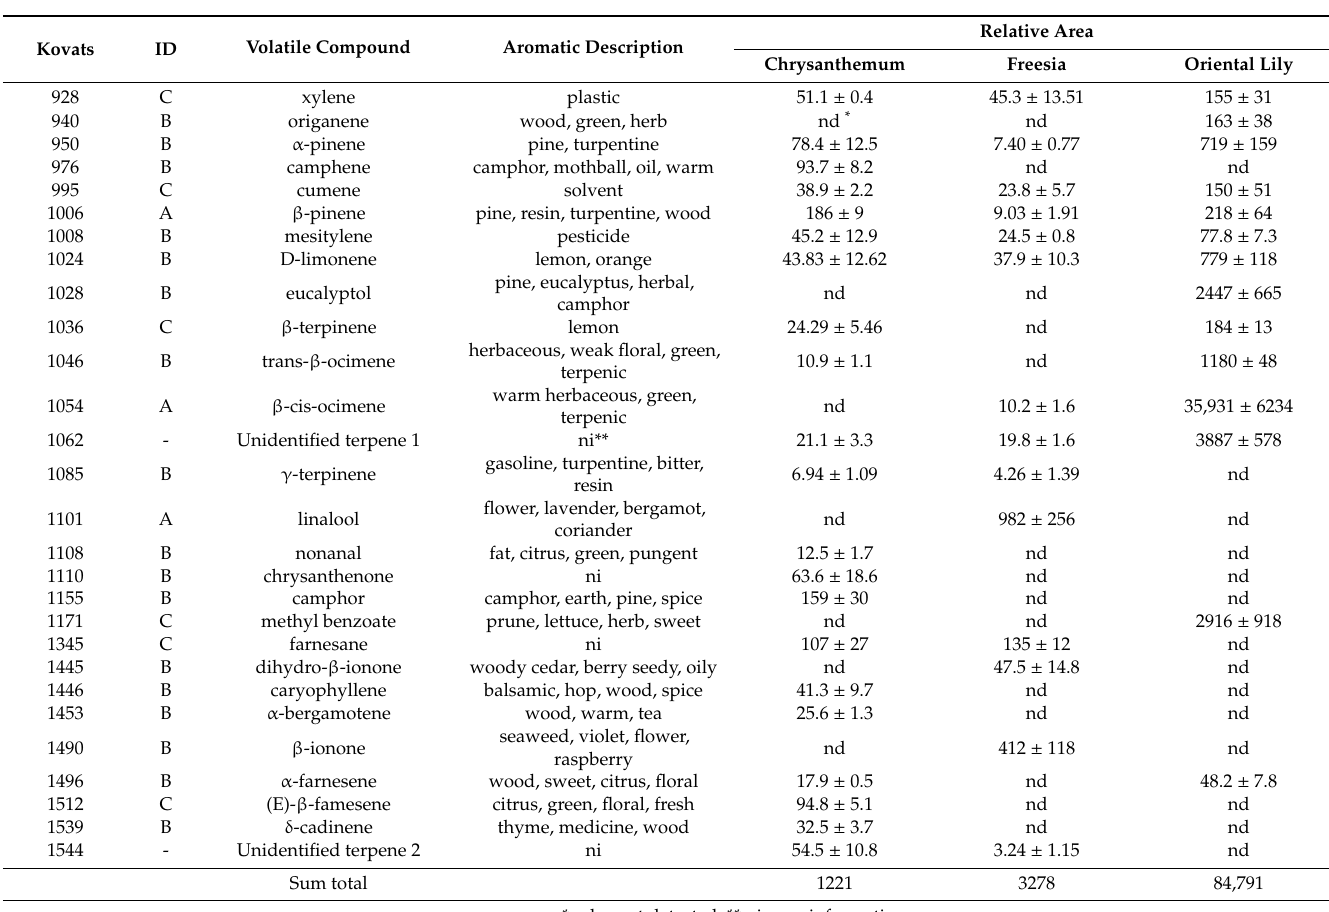
Table 2. List of volatile organic compounds (VOCs) detected through GC-MS from the headspace collection of freesia, oriental lily, and chrysanthemum flowers, indicating the retention time (min), aromatic description (www.flavornet.com), and relative areas ( ± STDEV, n = 3) normalized to 4-methyl-2-pentanol. ID: identification reliability. A, mass spectrum and Linear Retention Index (LRI) agreed with standards; B, mass spectrum agreed with mass spectral data base and LRI agreed with the literature data (Flavornet and Pherobase); C, tentatively identified, mass spectrum agreed with mass spectral